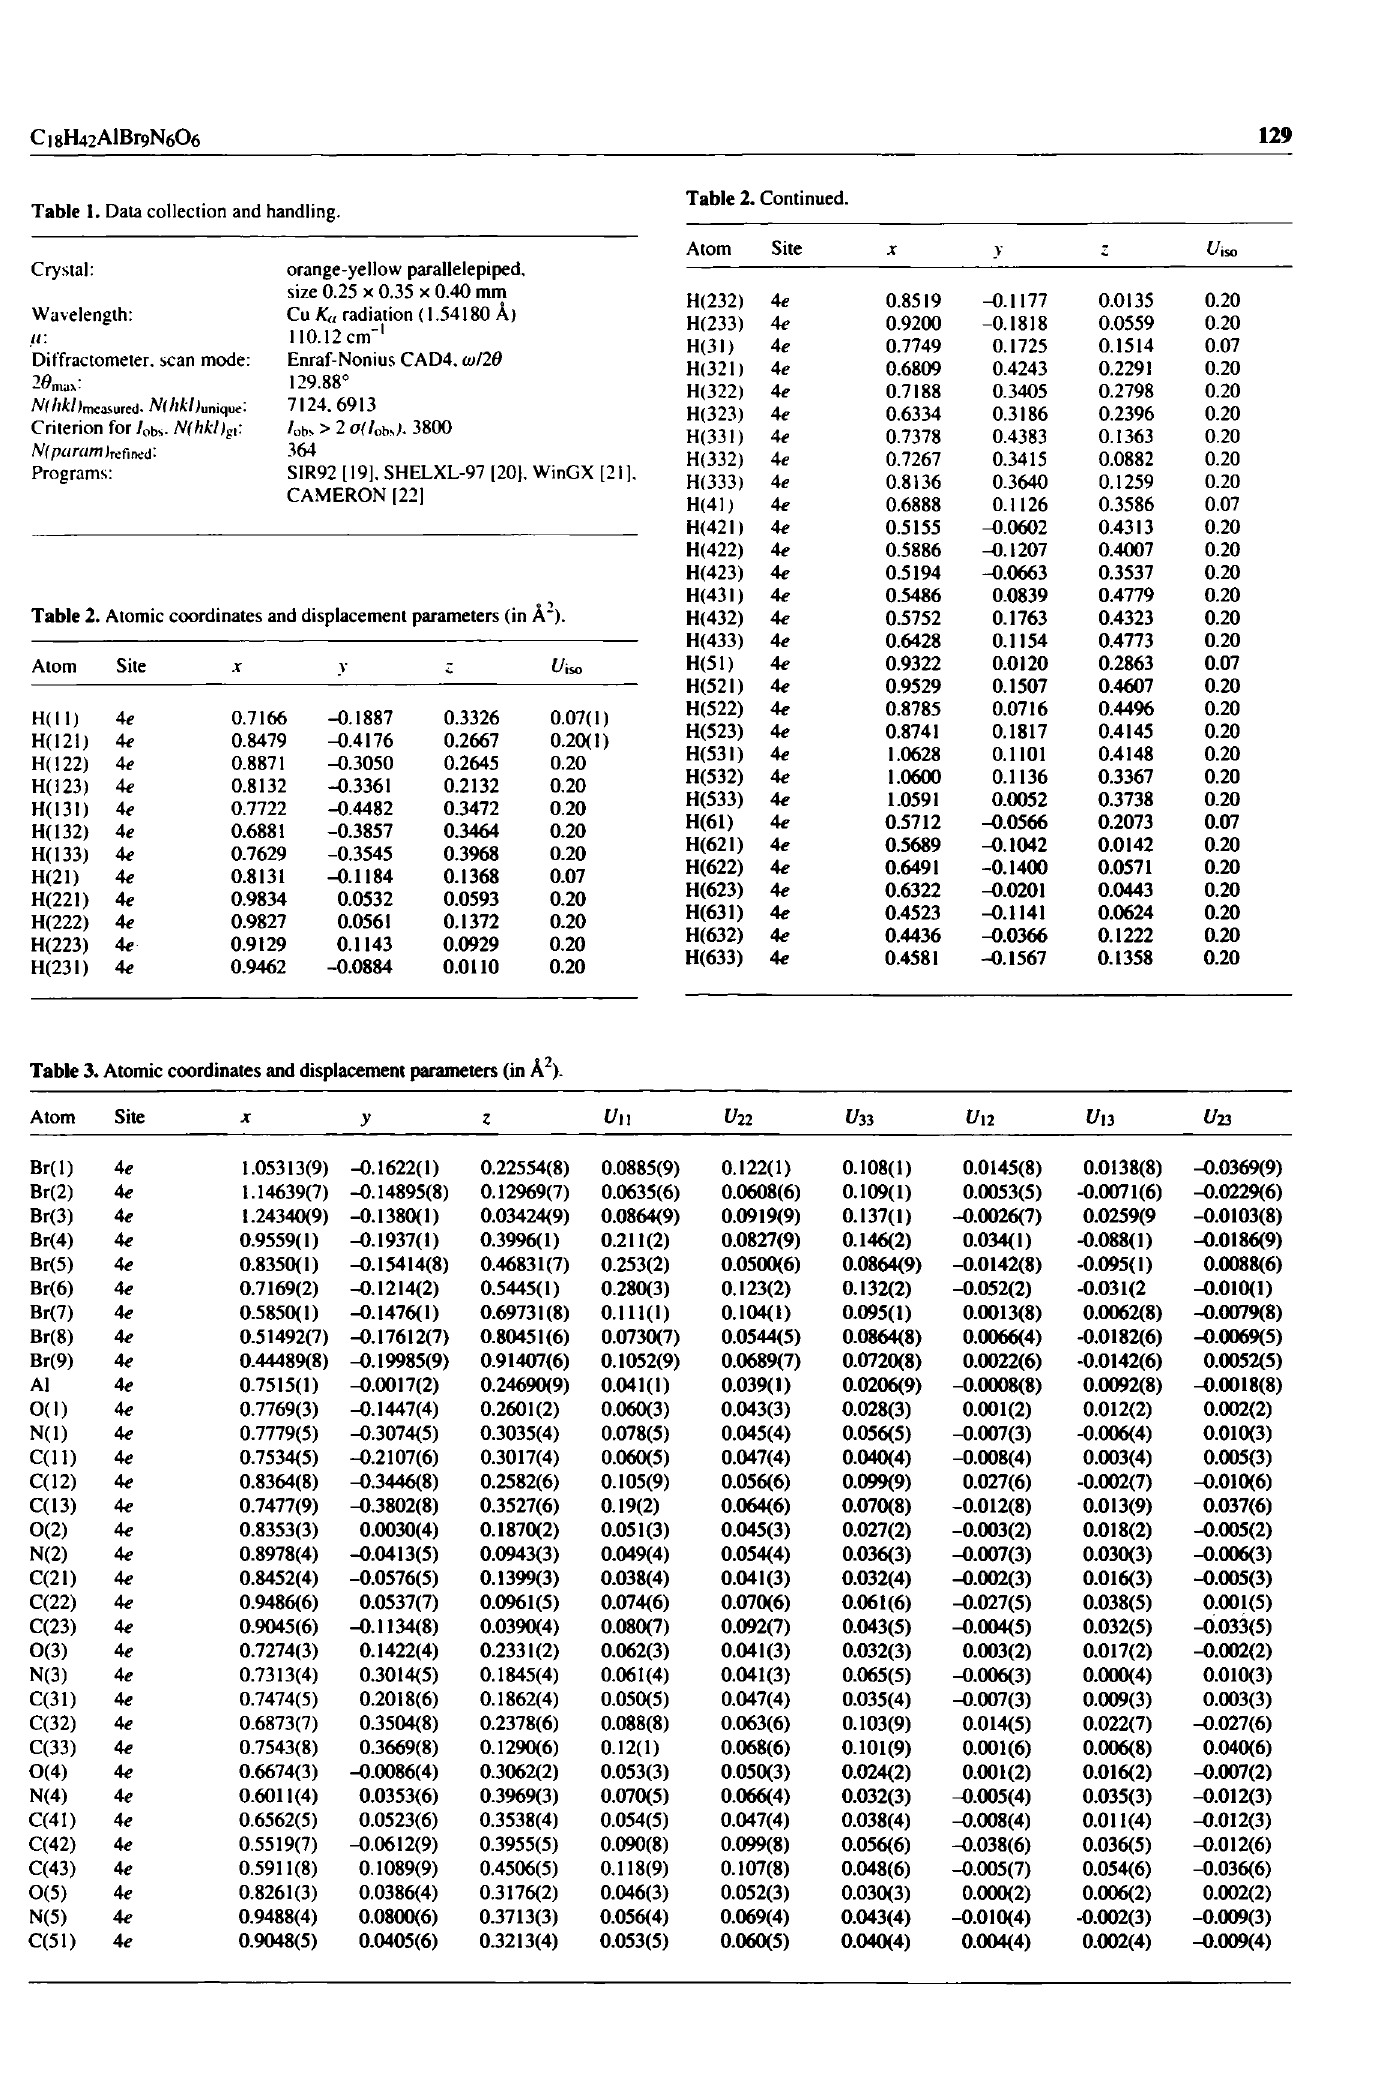
Table 1. Data collection and handling.